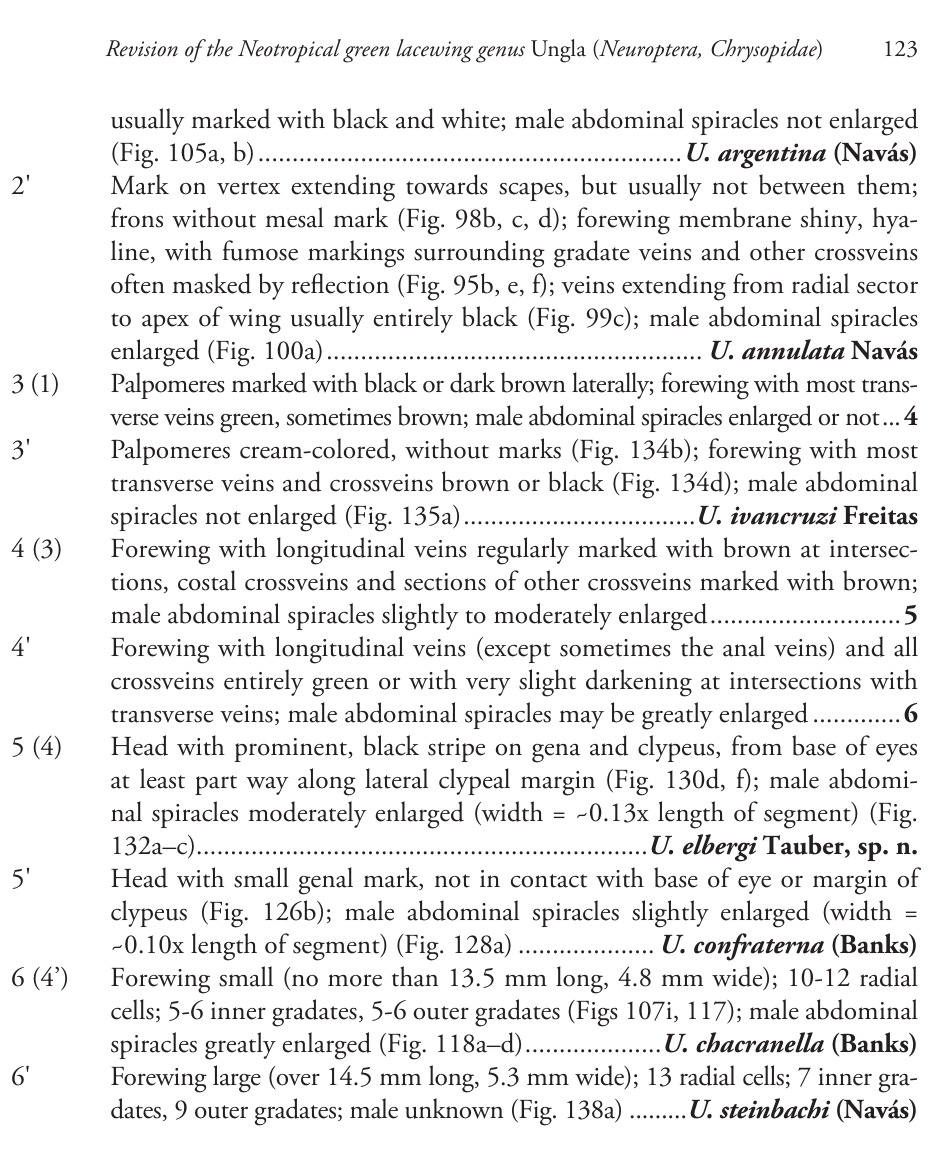
Figs 95–101 Ungla annulata Navás, 1914. Broteria (Zool.) 12: 224-225; “República Argentina: Huasán, Febrero de 1912 (Bruch.)”. Stange 1967: 41 (catalog); Adams 1975: 169 (synonym of Hypochrysa argentina Navás); Penny 1977: 16 (list, as synonym of H. argentina ); Brooks and Barnard 1990: 276 (tax, as synonym of U. argentina ); Monserrat 1985: 240 (type); Monserrat and Freitas 2005: 165 (tax, as synonym of U. argentina ); Oswald 2015 (catalog, as synonym of U. argentina ).